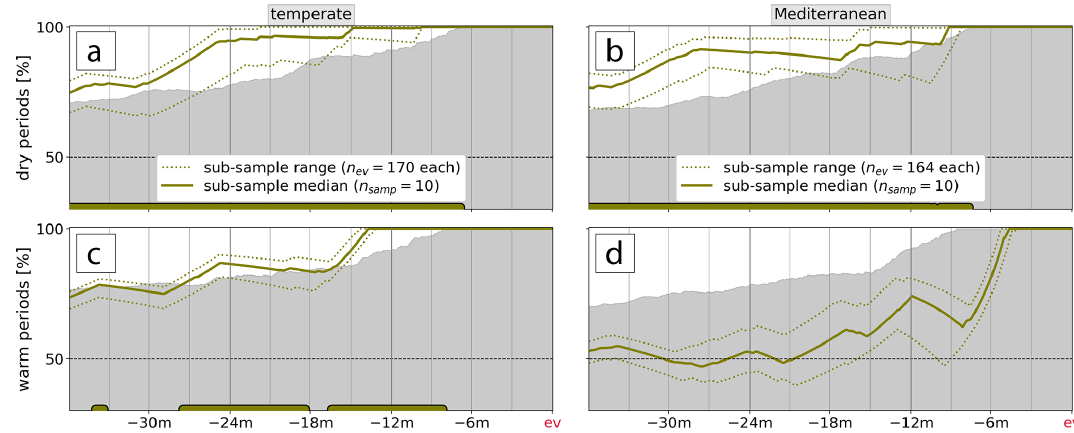
< 0) and (b, d) warm period ( T 2 m (cid:48) > 0) for decreasing 90d 90d